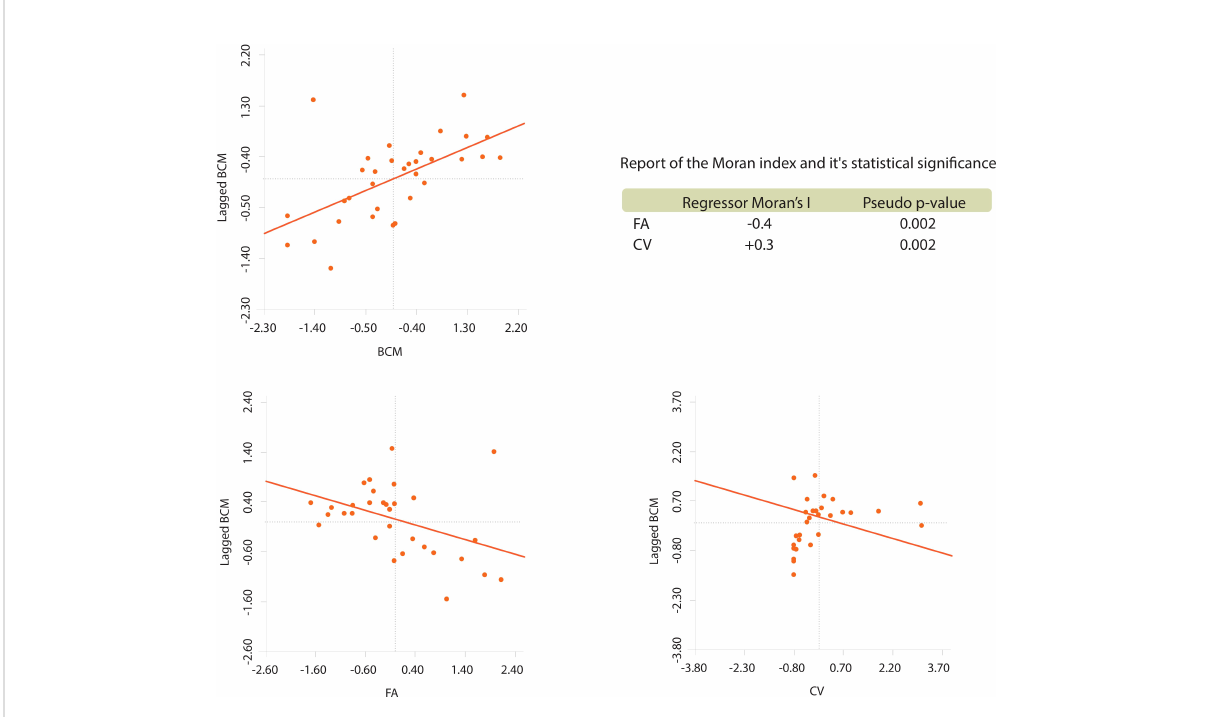
FIGURE 3 Univariate spatial analysis of BCM and bivariate of W_BCM against each